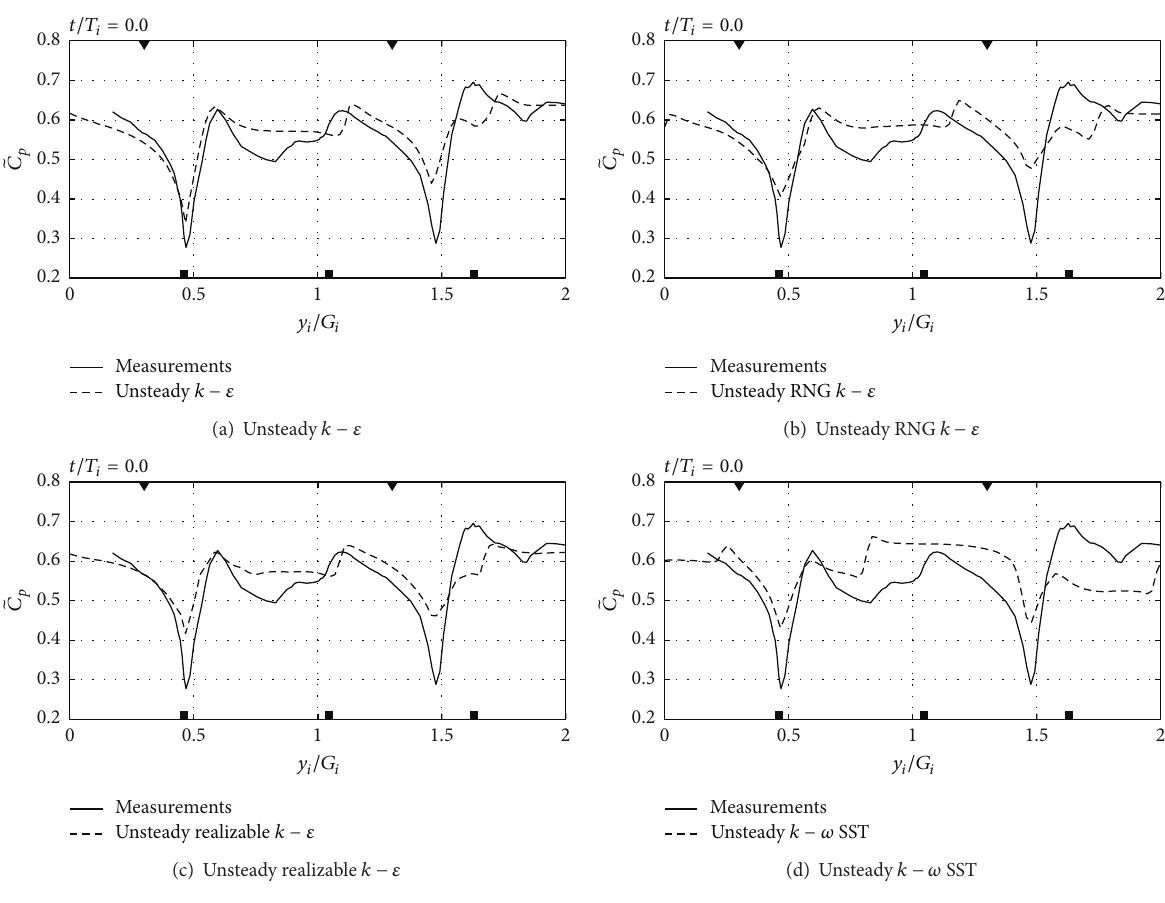
̃𝐶 𝑝 , in the radial gap (